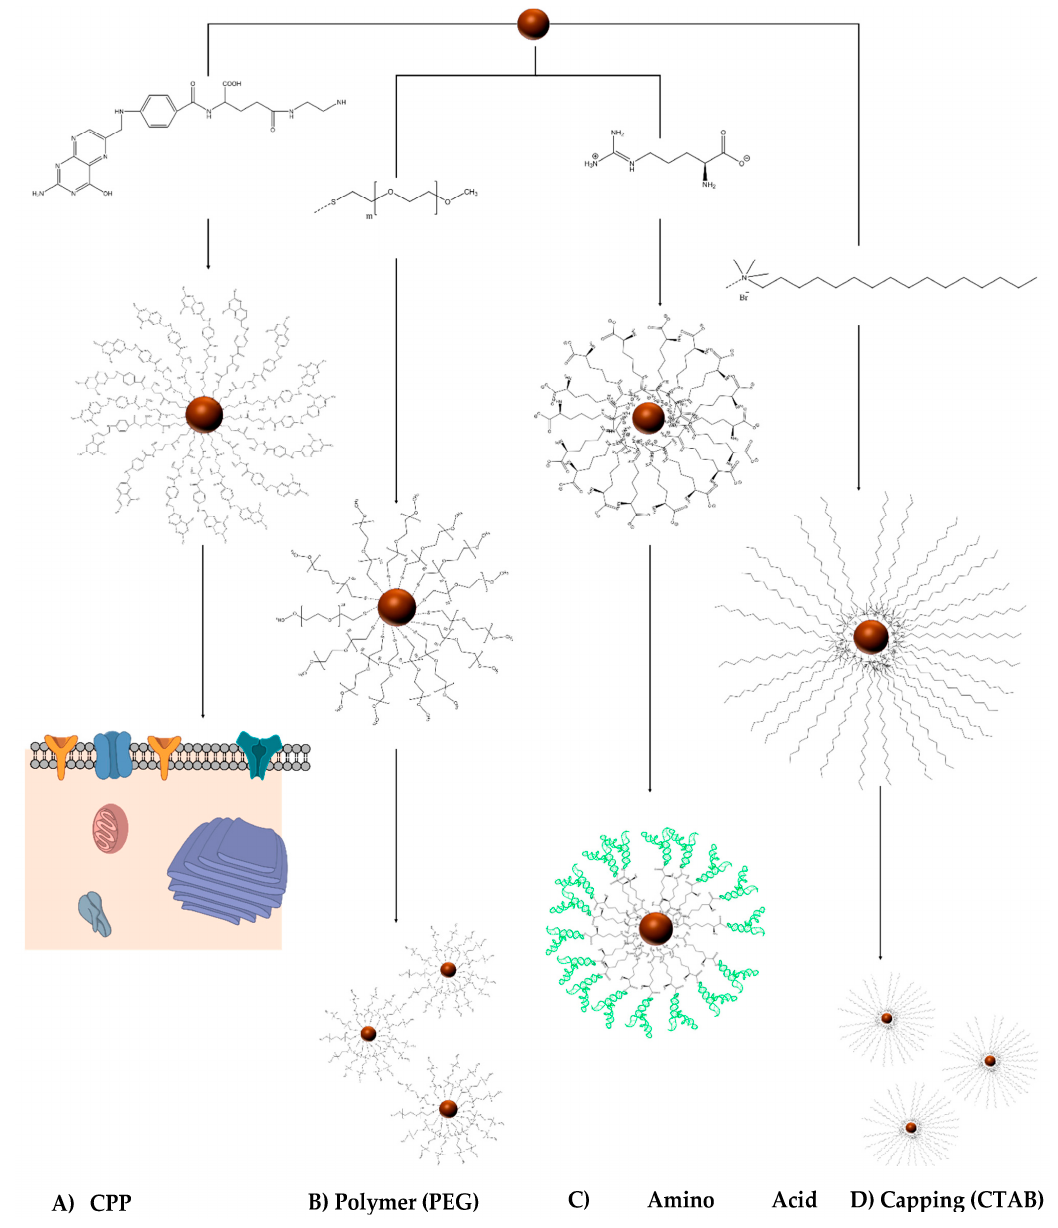
Figure 3. Examples of NP (Nanoparticle) modifications. ( A ) Cell-penetrating peptide-decorated NPs enhance cellular uptake of the NP ( B ) Polymer modifications such as PEG (polyethyleneglycol) (in figure) and PEI (polyethyleneimine) enhance NP stability by preventing aggregation in solution; ( C ) Amino Acid modifications such as arginine or lysine improve RNA binding to NP. Certain aptamers are synthesized with specific amino acid recognition motifs; ( D ) Surfactant capping modifications such as citrate, CTAB (cetyltrimethylammonium bromide) etc., have been used to restrict NP size, prevent aggregation, and improve stability in solution.